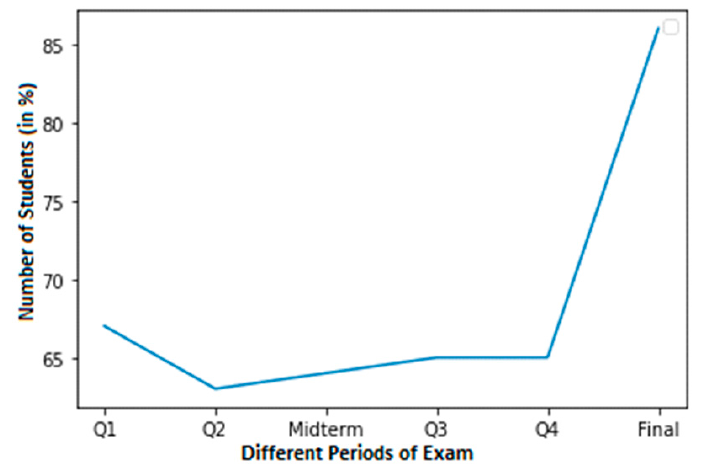
Figure 7. Less cheating increasing grades dataset 2 with cheating found.